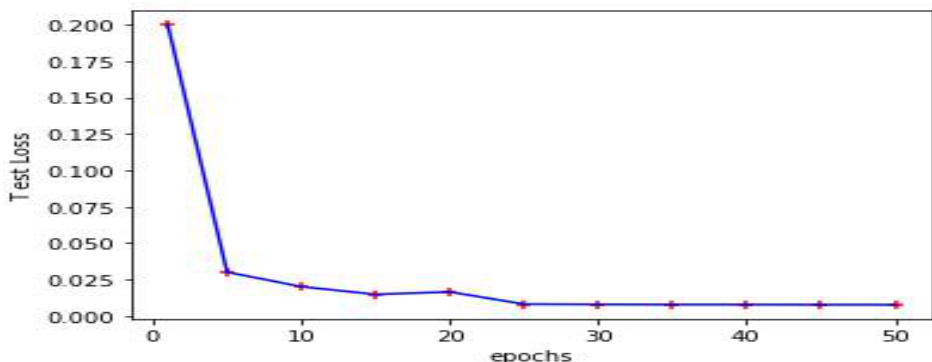
Figure 3. Loss (Sparse_categorical_crossentropy) with respect to the number of epochs when detecting